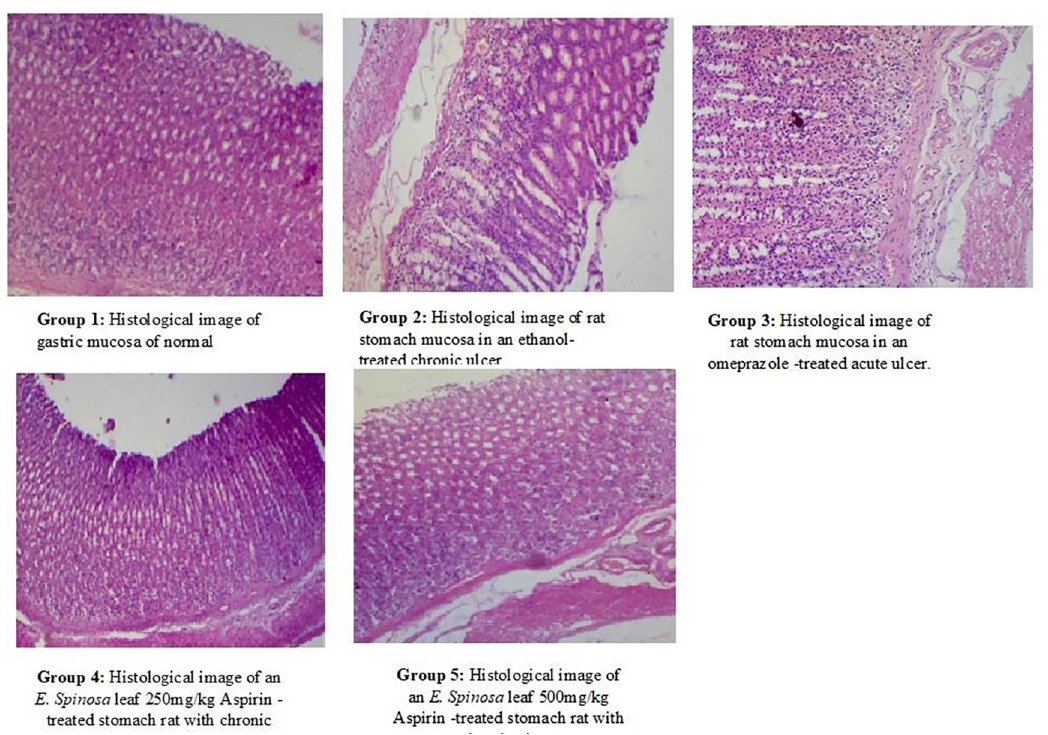
Fig 6. An aspirin-induced gastric Group 1–5 histological abnormalities such as edema, necrosis, hemorrhage, and congestion in the gastric lesion and mucosa layer. The thin section was examined at 100X magnification.